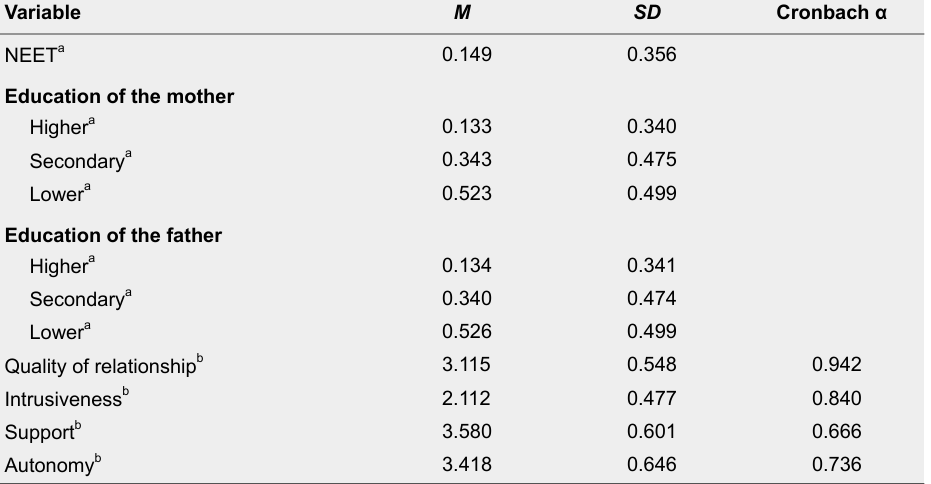
Summary Statistics of the Dependent and Independent Variables Used in the